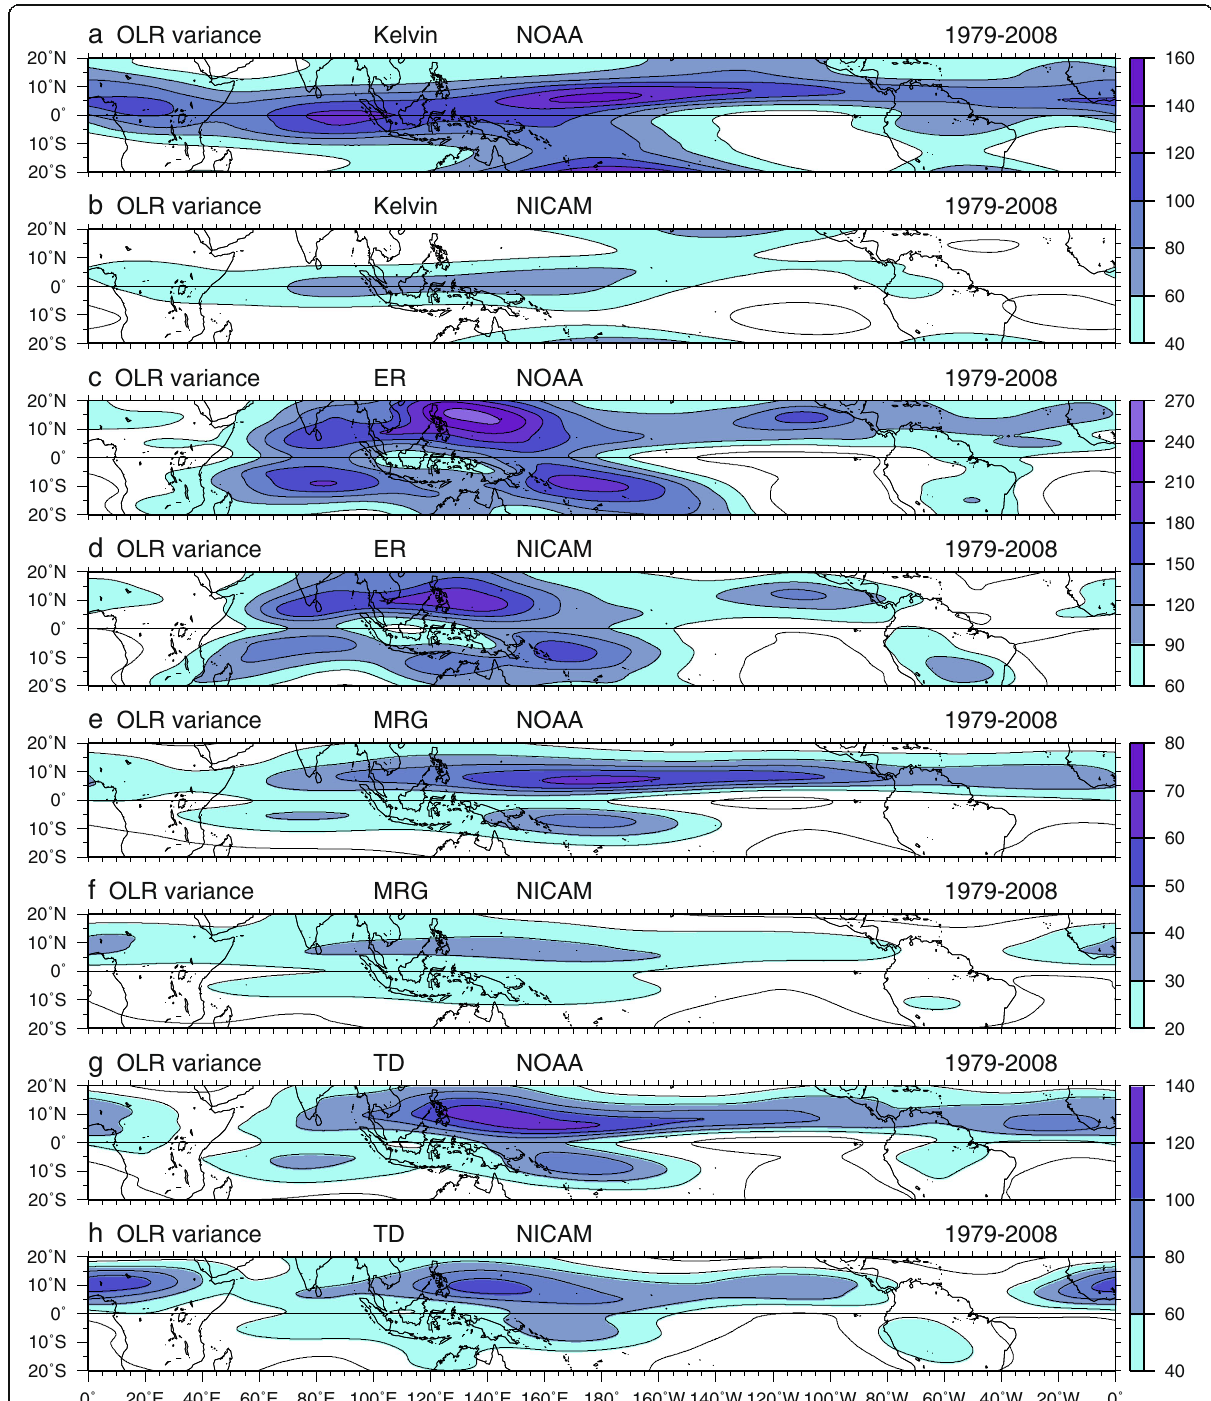
Fig. 10 Comparison of climatology of the OLR variances of equatorial waves between observation and simulation. Annual mean climatology (1979 – 2008) of the OLR variances in (W m − 2 ) 2 for Kelvin wave (Kelvin) ( a , b ), equatorial Rossby waves (ER) ( c , d ), mixed Rossby gravity waves (MRG) ( e , f ), and tropical depression waves (TD). The observed NOAA OLR variances are shown by ( a , c , e , g ), whereas the NICAM simulated OLR variances are shown by ( b , d , f , h